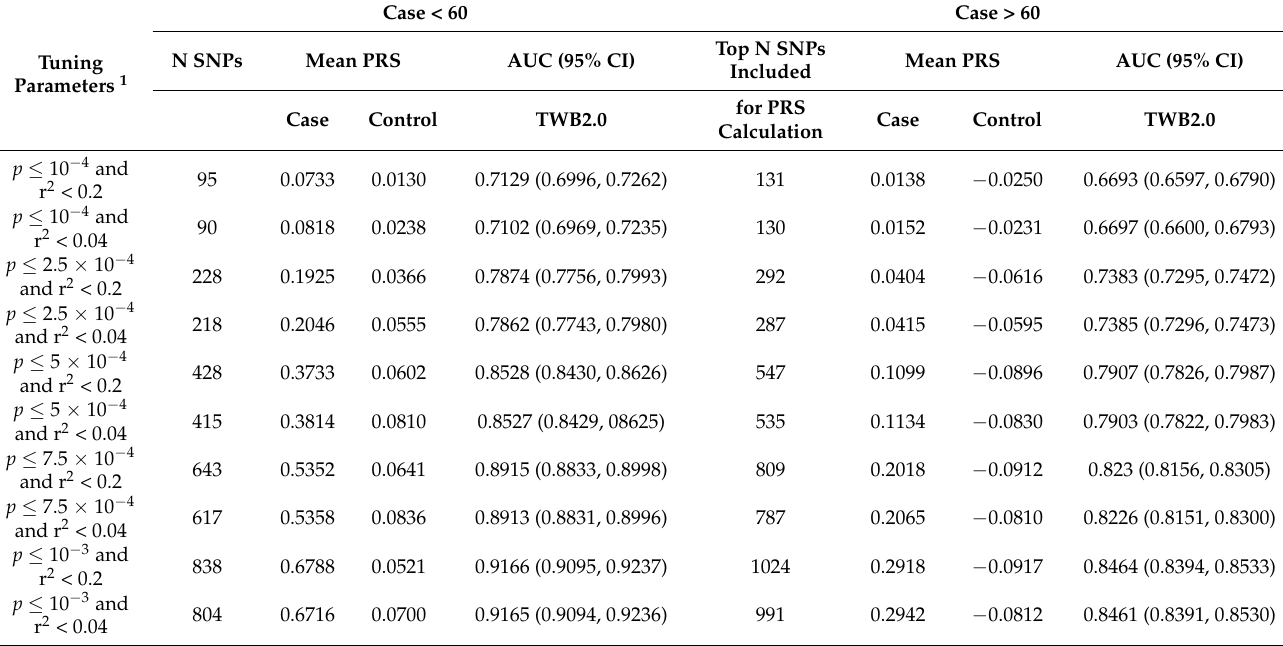
1 Tuning parameters, including genome-wide significance ( p ) and r 2 for LD clumping. The table shows that the mean PRS is higher among the cases than the controls across all PRS models. Abbreviations: SNP = single nucleotide polymorphism, PRS = polygenic risk score; AUC (95% C.I) = area under curve (95% confidence interval); TWB2.0 = Taiwan Biobank 2.0.